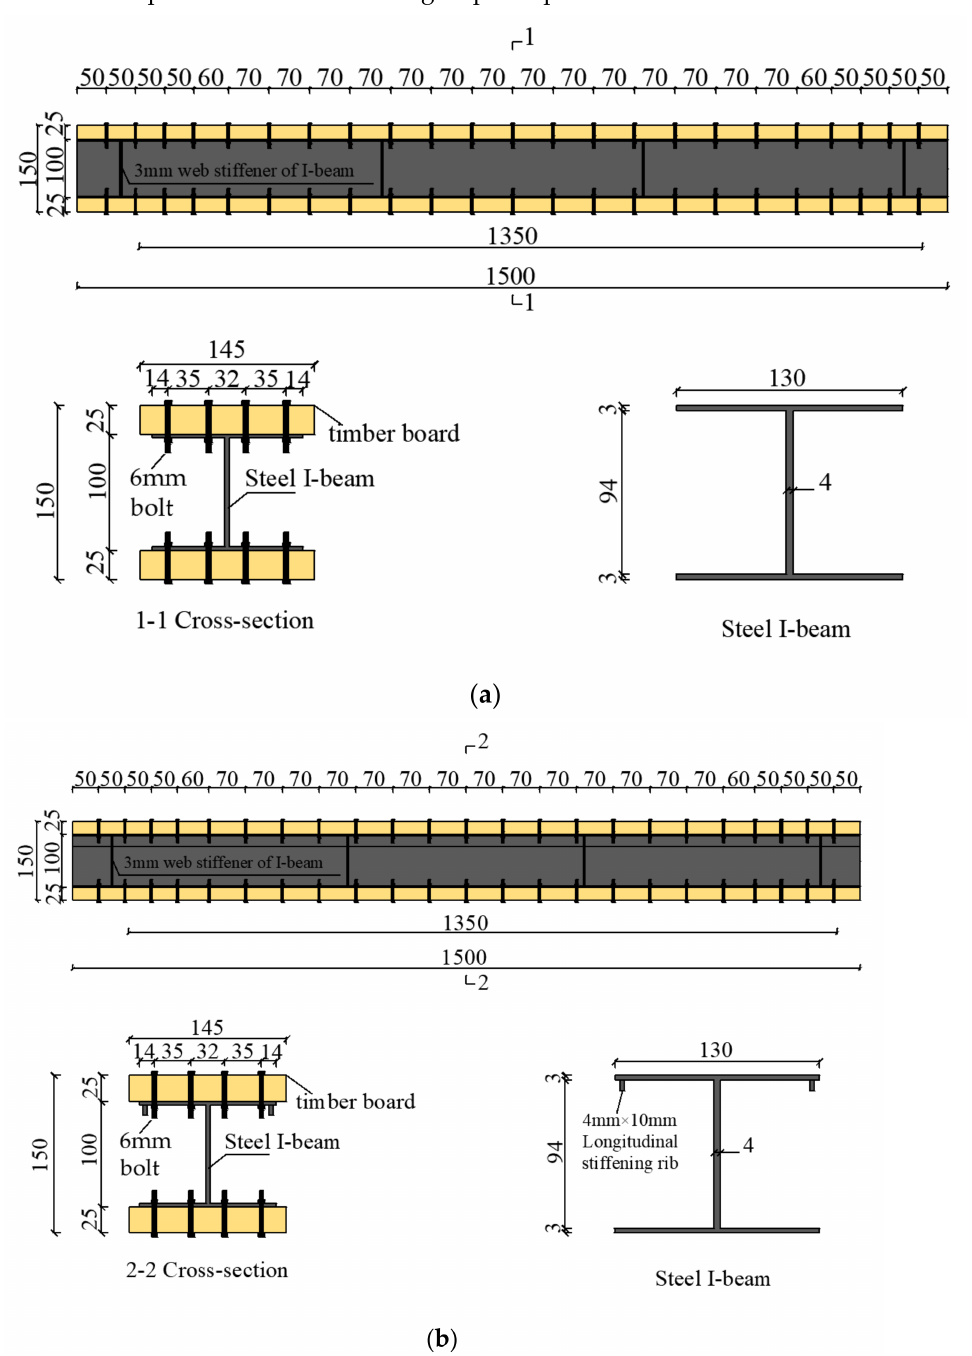
Figure 1. Construction of specimens of group L1 (unit: mm): ( a ) specimens without longitudinal stiffening ribs; ( b ) specimens with longitudinal stiffening